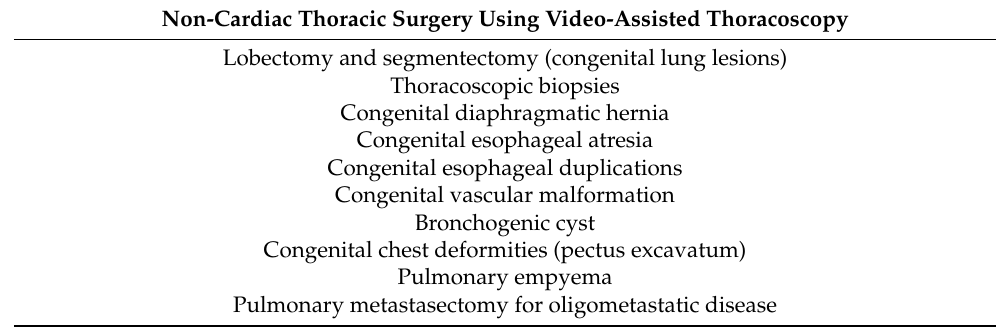
Table 3. Indications for non-cardiac thoracic surgery using video-assisted